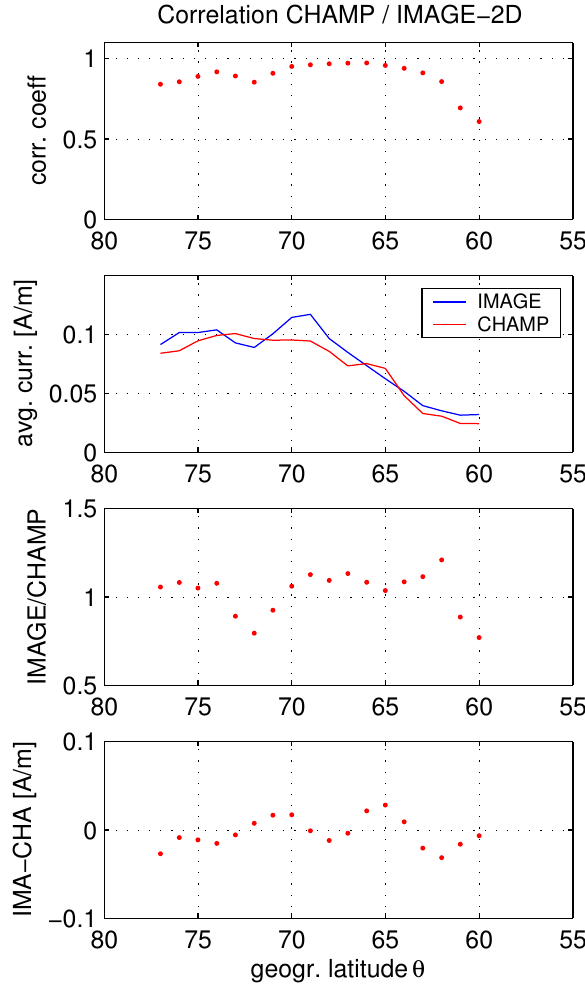
Fig. 10. Correlation analysis of the CHAMP versus IMAGE current estimates. From top to bottom: correlation coefficient R c , average current density, regression coefficients, i.e. amplitude ratio (inverse regression line slope) and regression bias (regression line intercept).